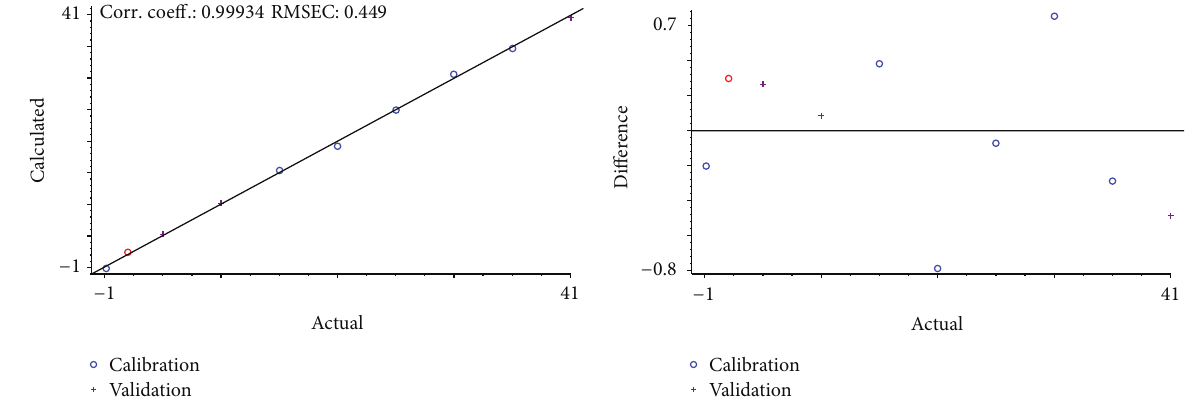
Figure 3: Relationship plot of actual FFA versus predicted FFA by FTIR with their differences.